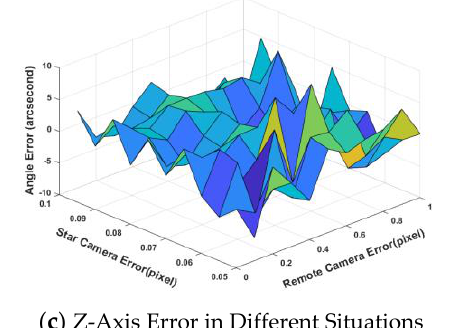
Figure 9. Triaxial deviation angle of calculated installation matrix under different errors of star camera and remote sensing camera by using the Wang’s algorithm. The unit of centroiding error is pixel for X and Y -axis and arc-second for Z -axis. Table 4. The Deviation Angle Error of Di ff erent